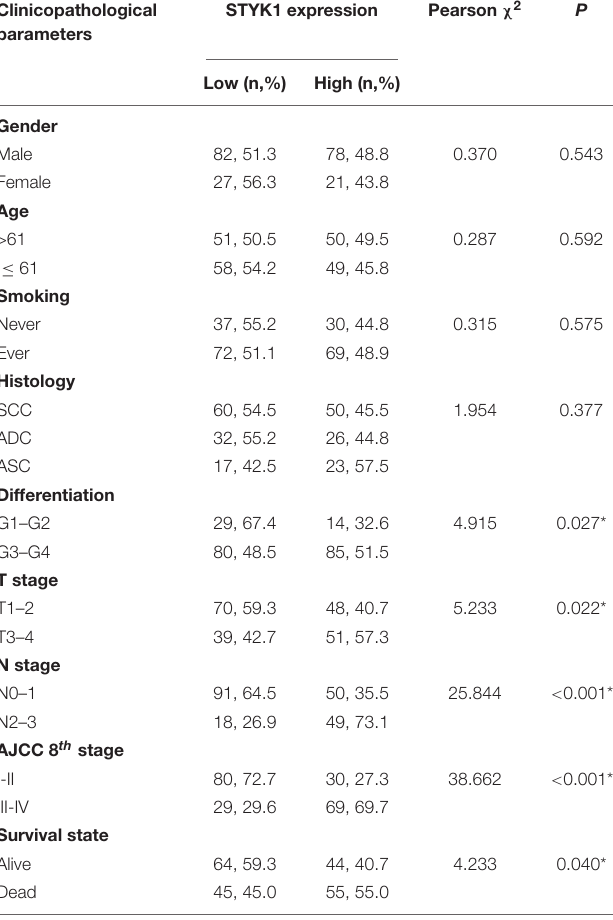
TABLE 1 | Relationship between clinicopathological features and STYK1 expression in patients with NSCLC. Clinicopathological STYK1 expression Pearson χ 2 parameters